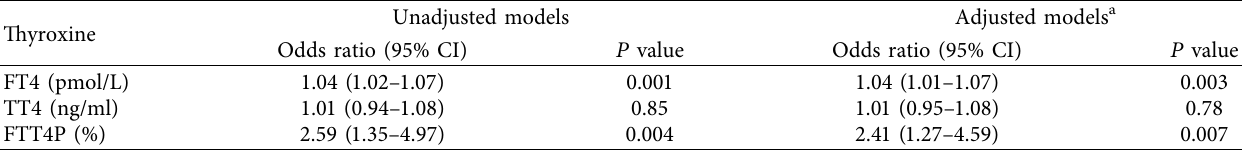
Table 2: Odds ratios for the risk of congenital heart defects.